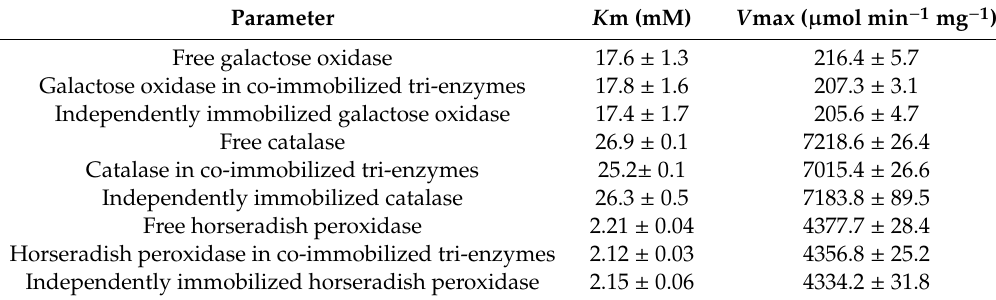
Table 3. Comparison of the kinetic parameters of free enzymes, co-immobilized enzymes, and independently immobilized